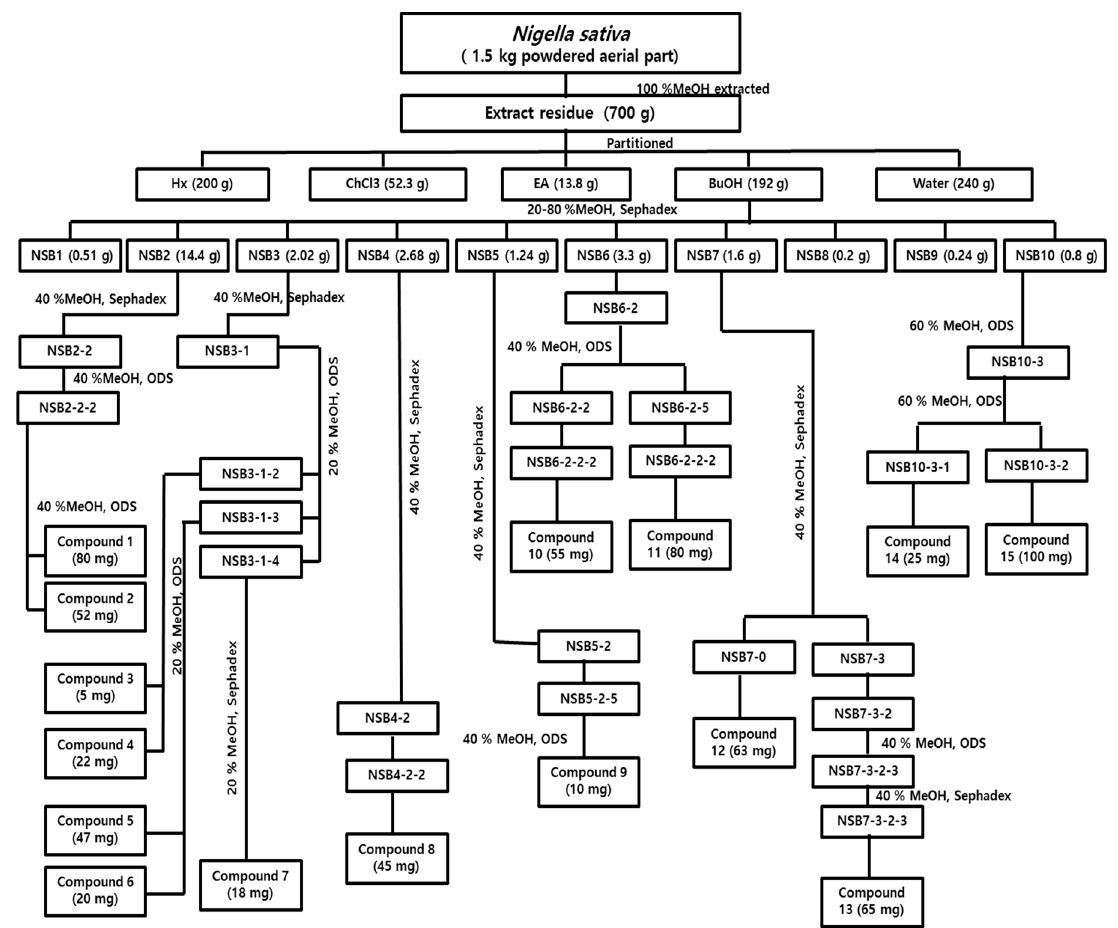
Figure 1. Isolation scheme for Nigella sativa.